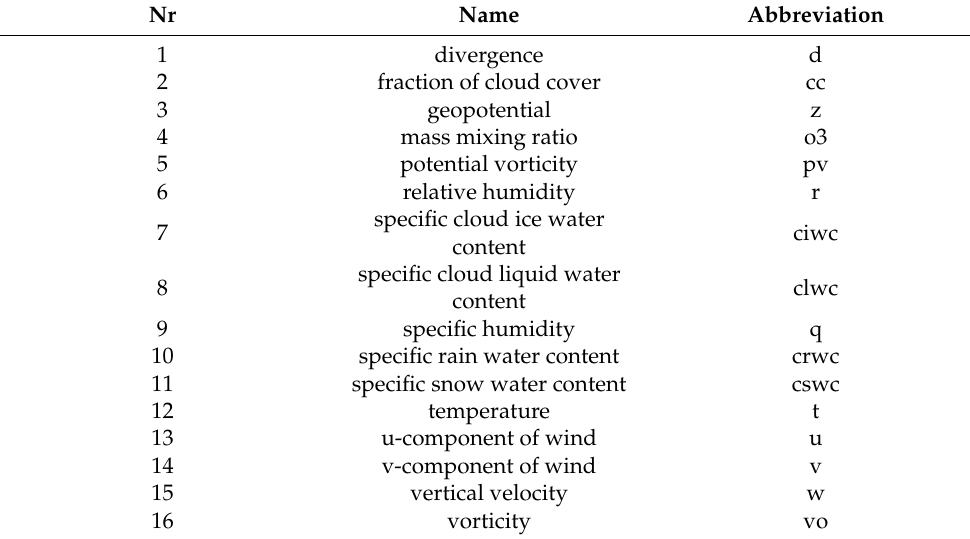
Table 1. ERA5 pressure level variables.